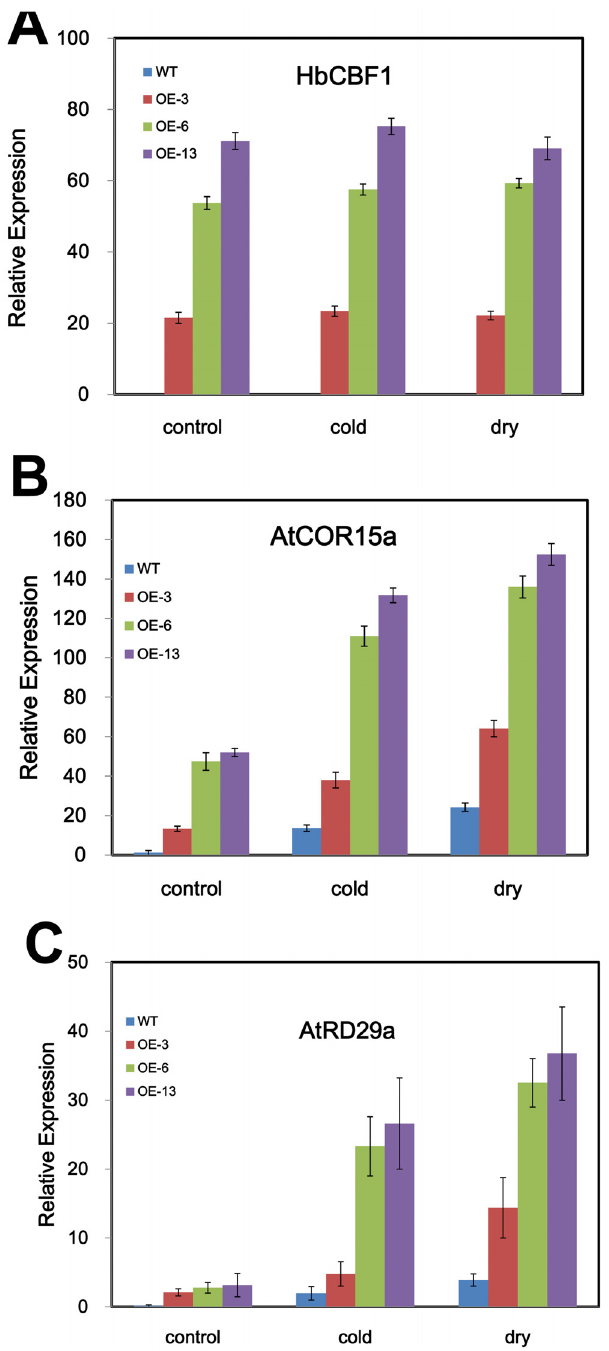
Fig 6. HbCBF1 overexpression activated the expression of COR15a and RD29a genes in Arabidopsis . (A) HbCBF1 , (B) AtCOR15a and (C) AtRD29a expression in col-0 , OE-3, OE-6 and OE-13 plants under